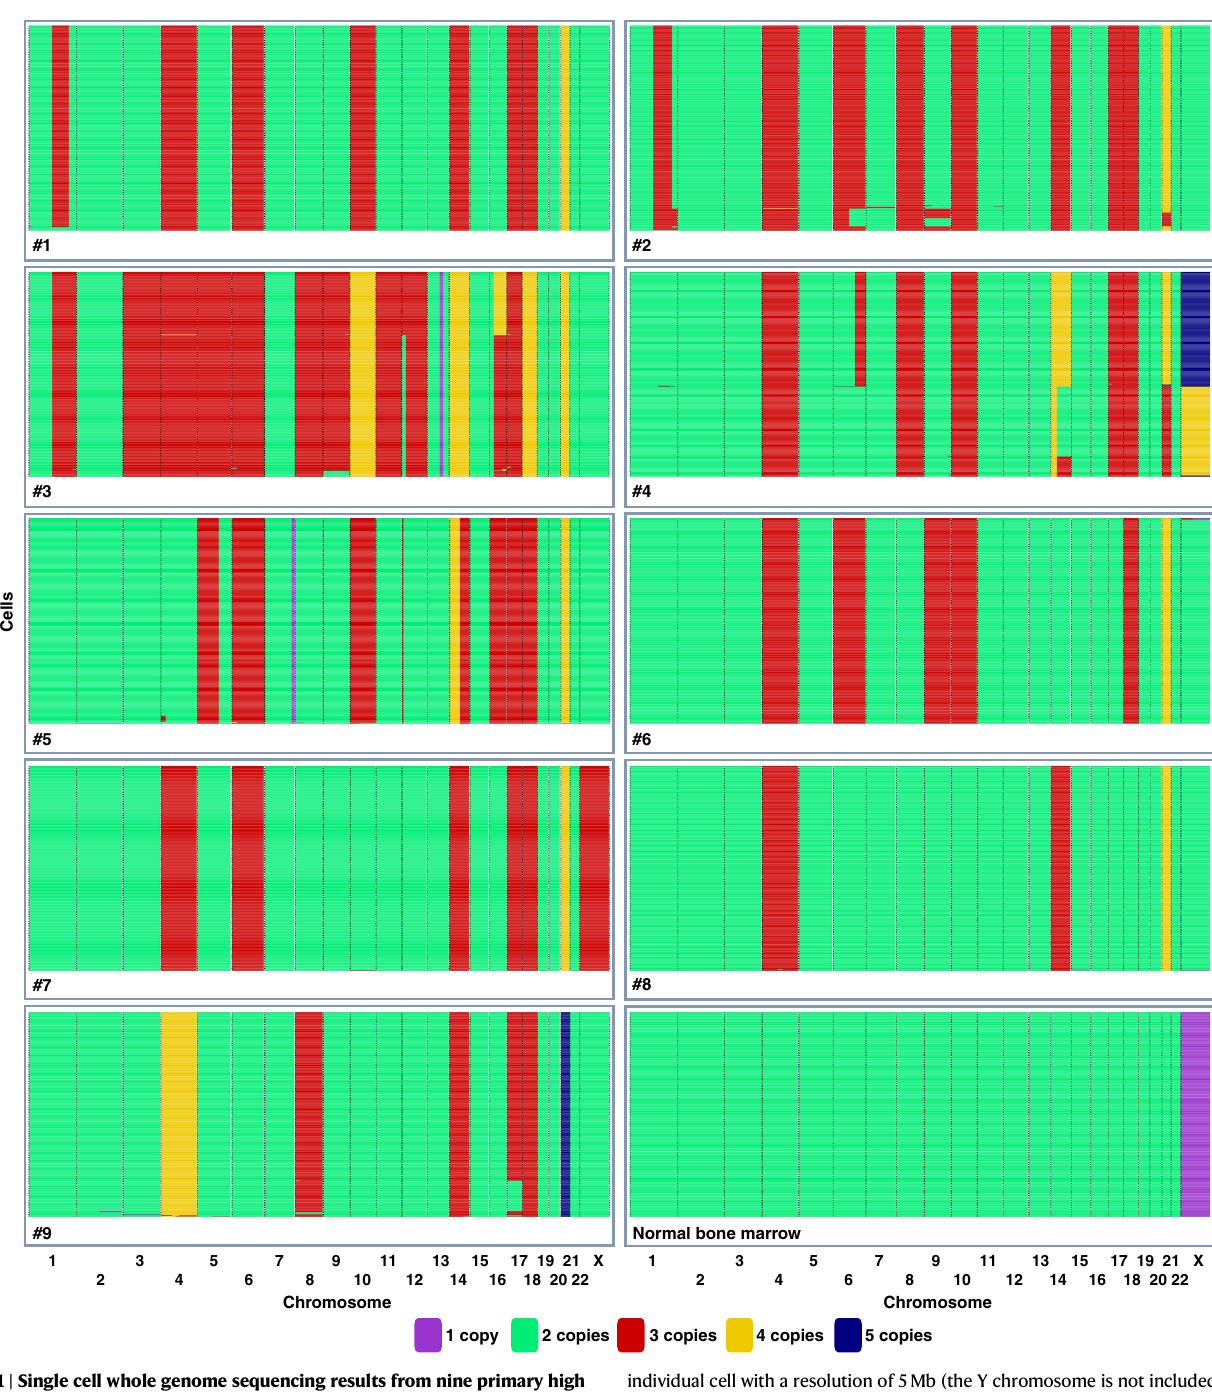
individual cell with a resolution of 5Mb (the Y chromosome is not included). Overall, only low to very low levels of copy number heterogeneity was seen. Cre- ated with BioRender.com. Source data are provided as a Source Data fi